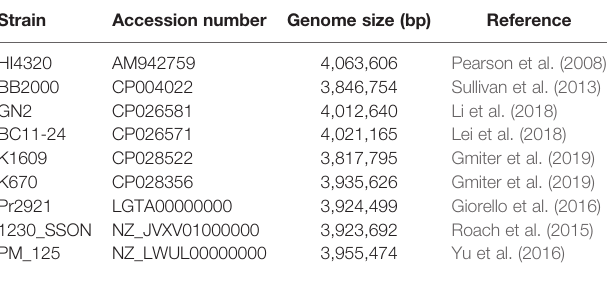
TABLE 1 | Proteus mirabilis genomes used in the